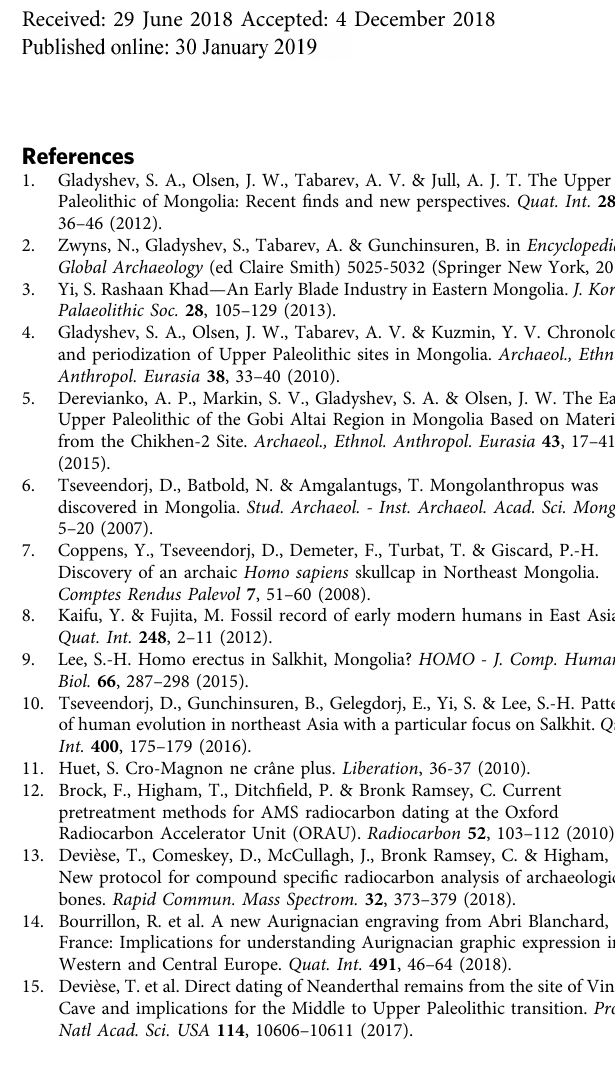
Fig. 5 Maximum parsimony phylogeny relating the Salkhit mtDNA to ancient and present-day human mtDNAs. a Subtree of the N haplogroup (Hg) phylogeny structure extracted from a global tree including all the mtDNAs diversity found in ancient and present-day anatomically modern human (Supplementary Fig. 3). The tree was obtained in MEGA6 (30, 31) and is #1 out of 3 most parsimonious trees putting in a phylogenetic network 58 ancient and 55 present-day modern human mtDNA including the Salkhit sequence. The mtDNA sequence of a Neanderthal from Altai is used as outgroup. The percentage of replicate trees in which the associated taxa clustered together in the bootstrap test (1000 replicates) are shown next to the branches. b Diagnostic positions of the N haplogroup and positions of the substitutions accumulated in the Salkhit mtDNA since its divergence from the common ancestor of the N haplogroup, indicated along the branch, are obtained using mtPhyl